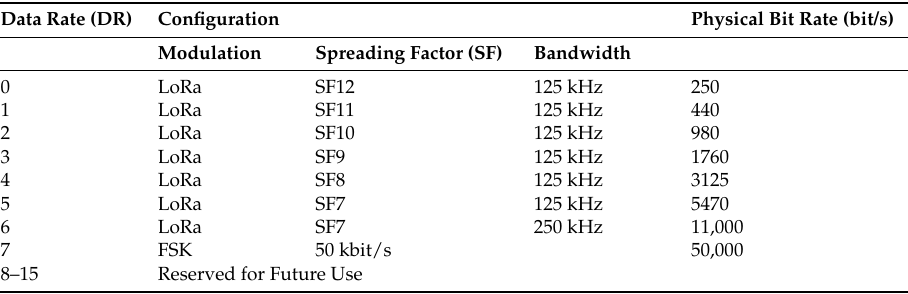
Table 3. Data rates and related configuration for EU863-870 band